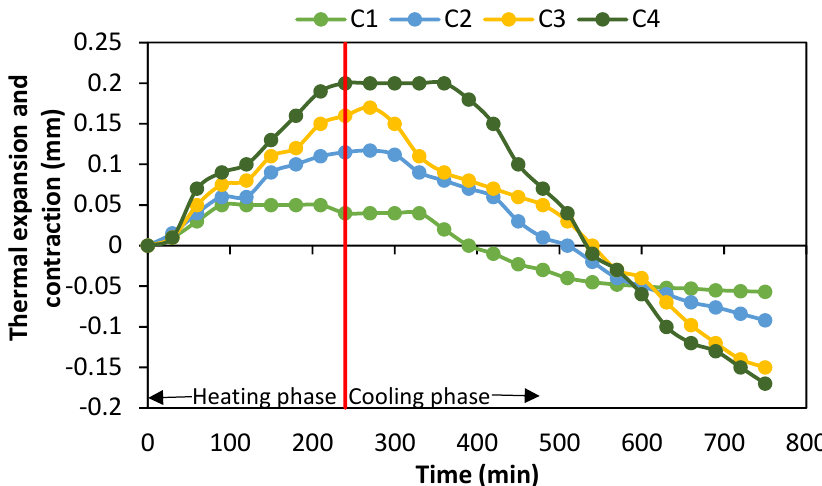
Figure 21. Thermal expansion and contraction of the specimens with respect to time.